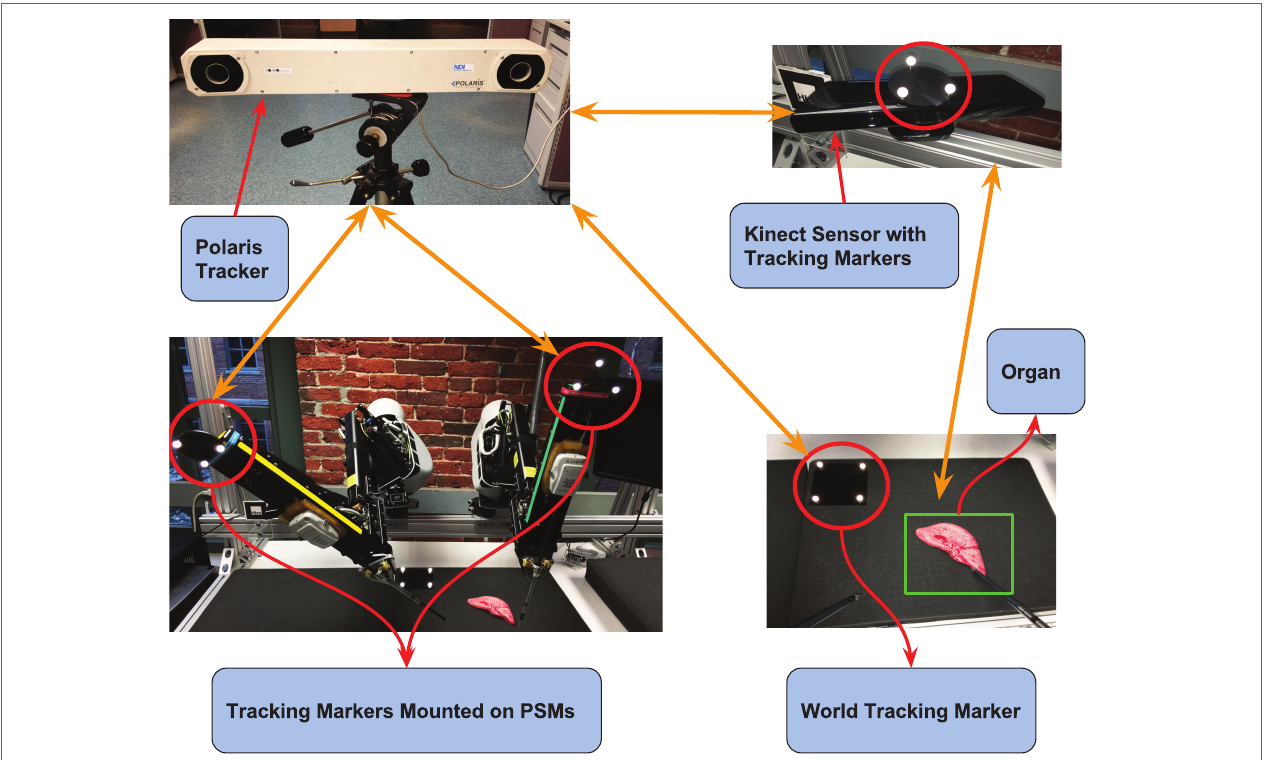
FIGURE 2 | An overview of the components and their interface with each other to enable haptic feedback . The Polaris Optical Tracker tracks the tracking markers mounted on the PSMs, the Kinect Sensor, and the World Frame. The Kinect Sensor tracks the organ/surgical